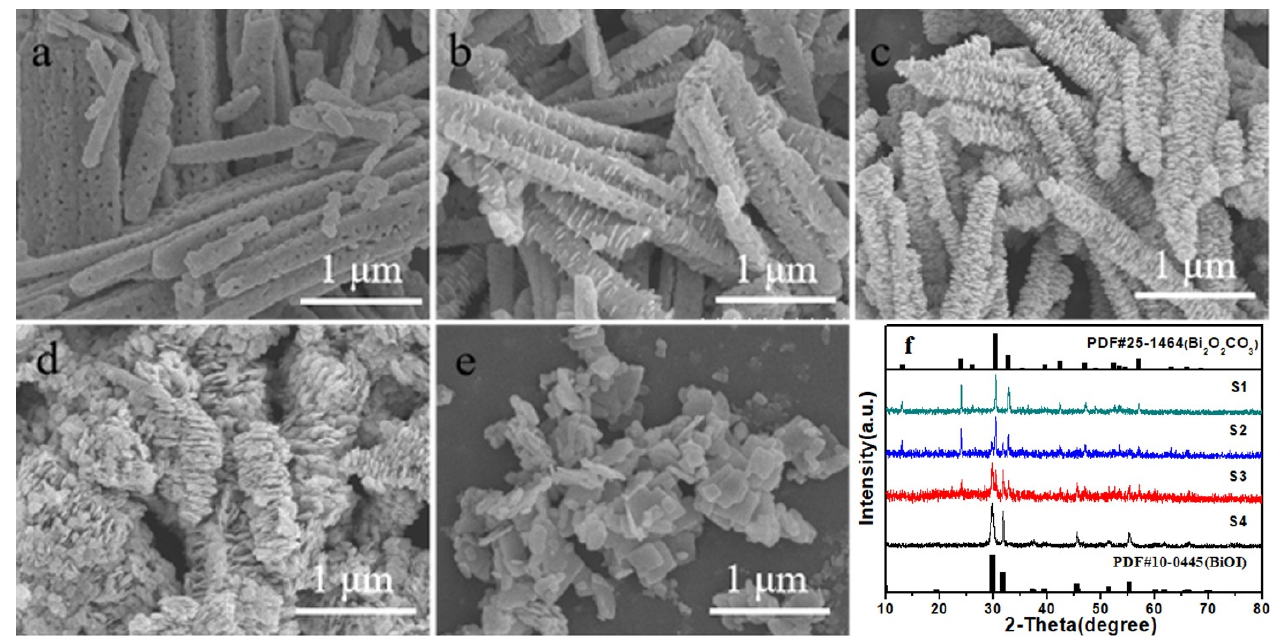
Figure 1. FE-SEM images of ( a ) pure Bi 2 O 2 CO 3 nanorods, Bi 2 O 2 CO 3 –BiOI heterojunctions of ( b ) S1, ( c ) S2, ( d ) S3, ( e ) pure BiOI. ( f ) XRD patterns of Bi 2 O 2 CO 3 –BiOI heterostructure (S1–S4) and Bi 2 O 2 CO 3 .